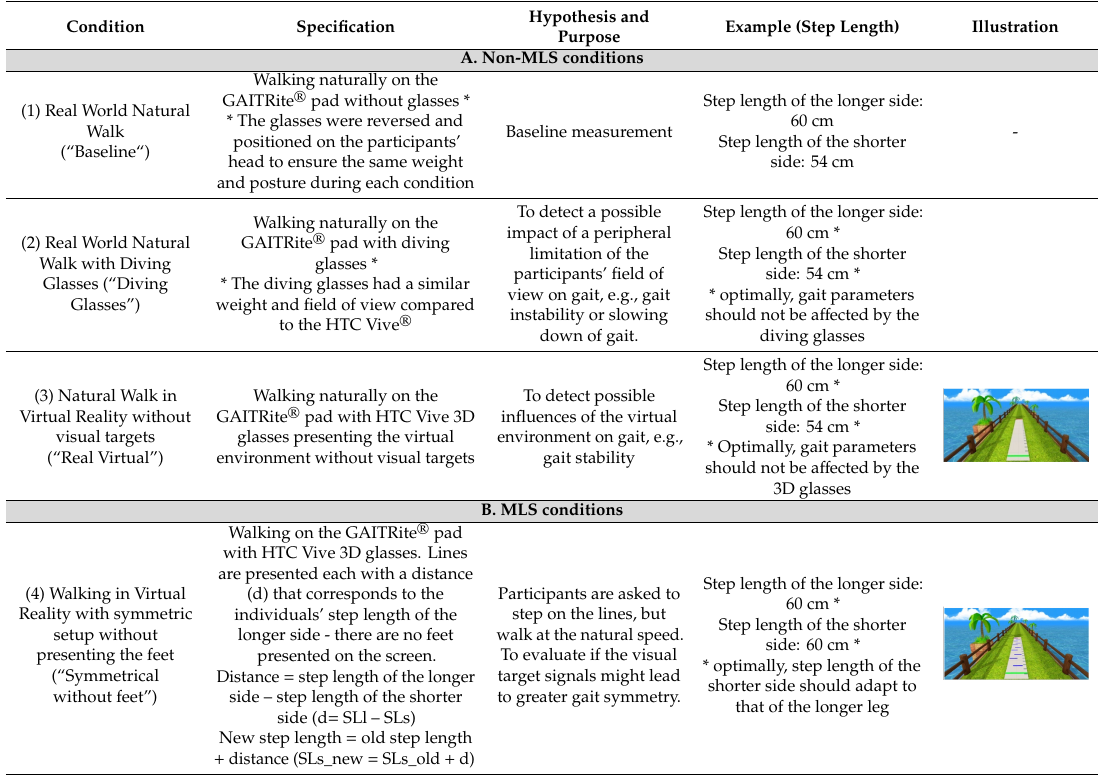
Table 2. Overview of experimental conditions and